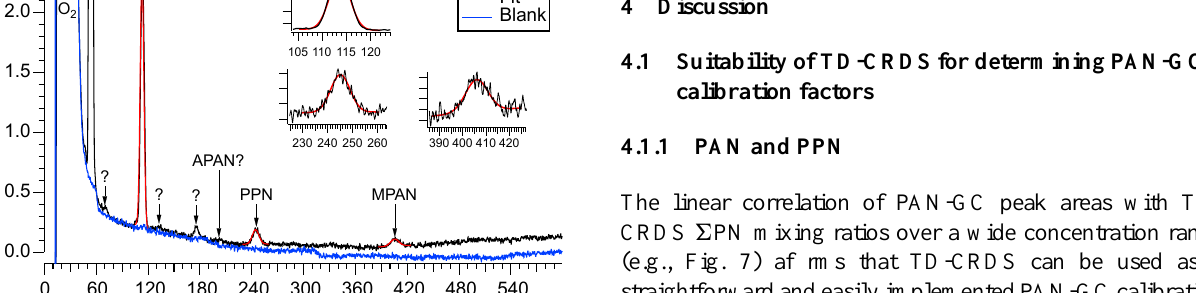
540480420360300240180120600 Migration time (s) Figure 12. Chromatogram of ambient air acquired during FOSSILS on 4 September 2013, 15:30 local time, and of the zero air blank ac- quired at 17:30 local time using a 10.4m RTX-1701 column at a He flow rate of 20.0mLmin − 1 . The chromatograms were smoothed before presentation (algorithm: Savitzky–Golay, fourth order, 41 data points, ∼ 2s). The red lines are fits of Eq. (1) to the observed peaks, which are superimposed as inserts for clarity. The peak areas correspond to the following mixing ratios: PAN: (121 . 5 ± 1 . 5)pptv, PPN: (13 . 6 ± 0 . 2)pptv, and MPAN: (10 . 2 ± 0 . 3)pptv.